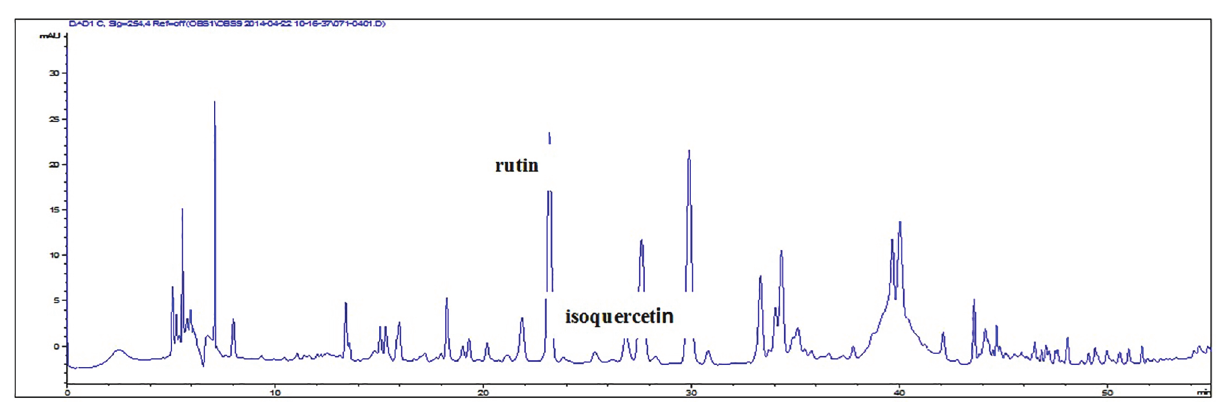
FIGURE 1 - HPLC chromatogram of O. albiflora.